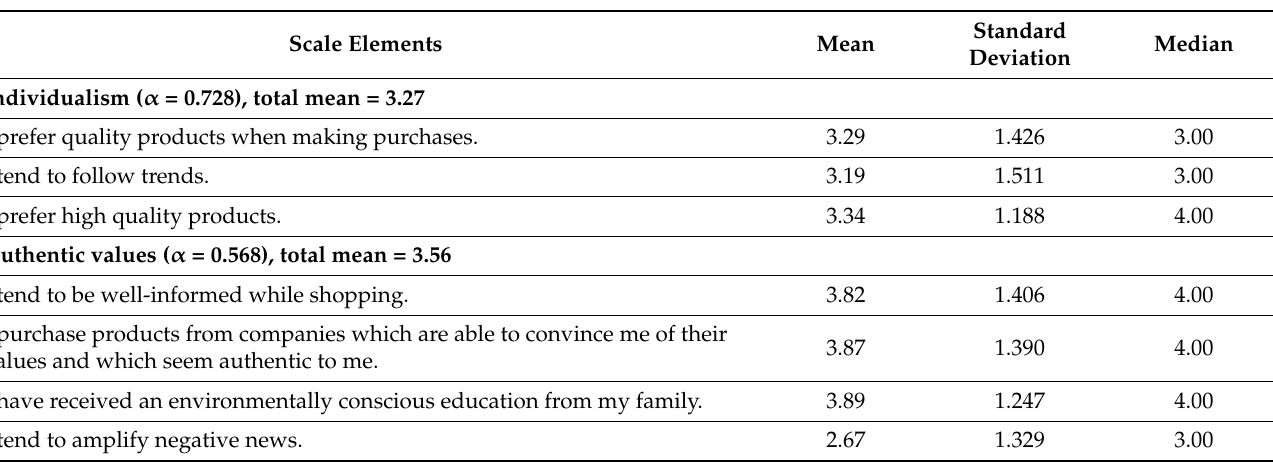
Standard Deviation